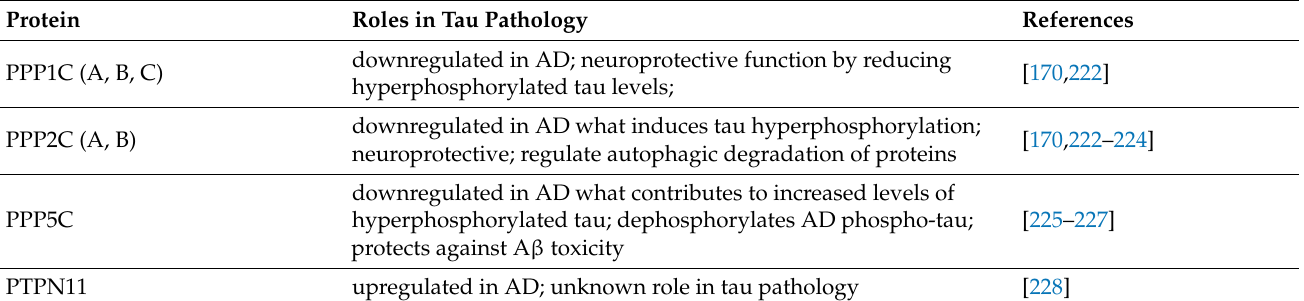
Table 3. Overview of protein phosphatases interacting with tau protein and their roles in pathology.